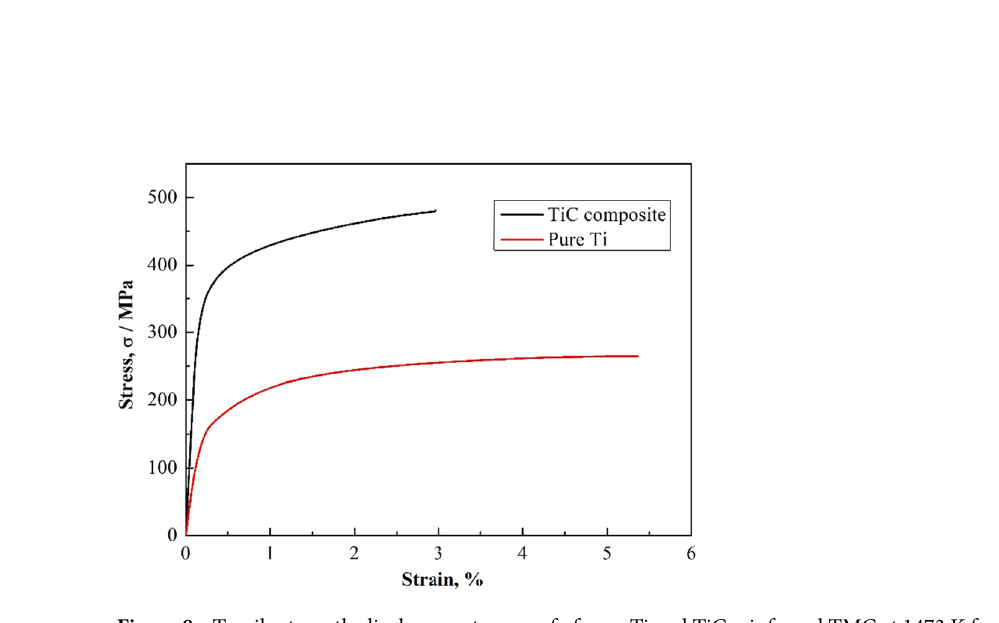
Figure 8. Tensile strength-displacement curve of of pure Ti and TiC reinforced TMC at 1473 K for 3.6 k